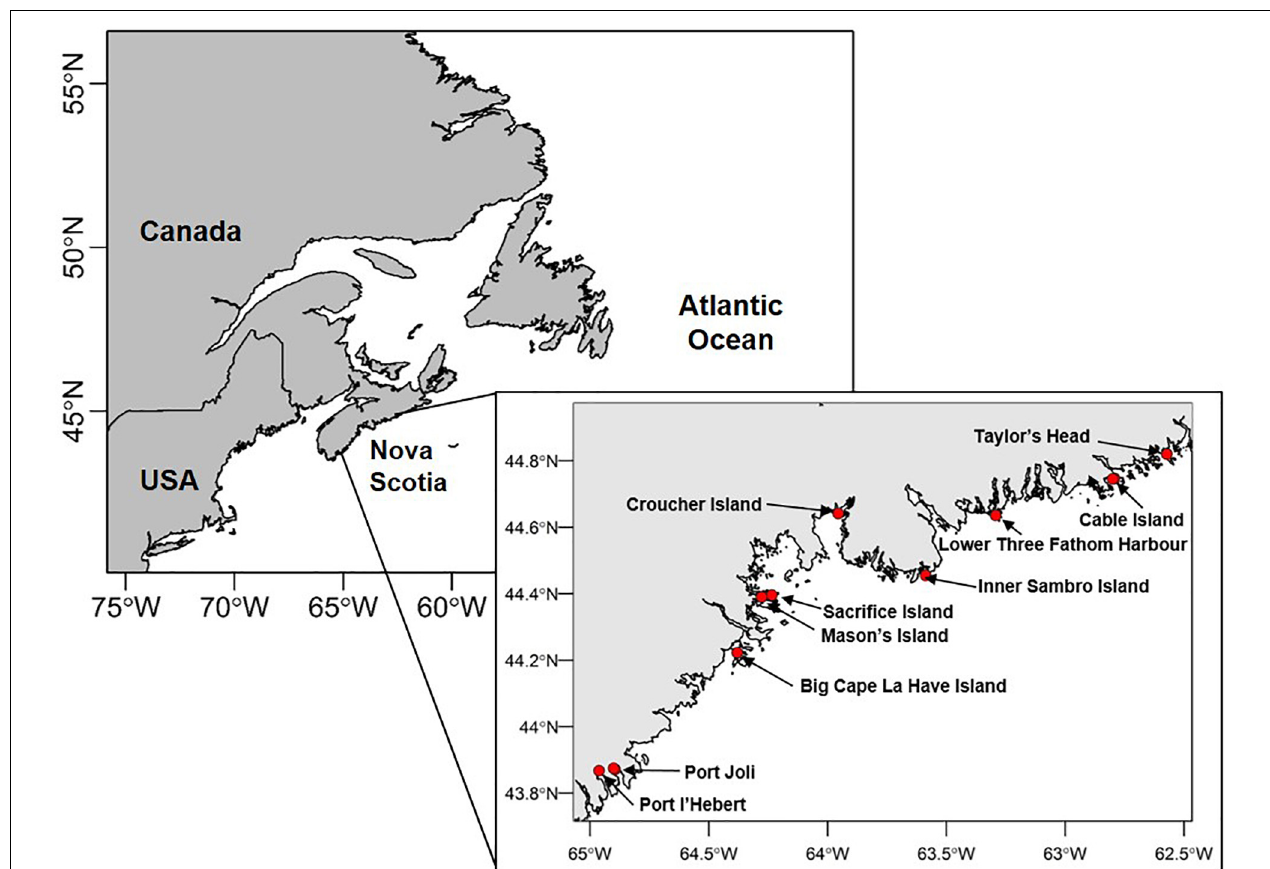
FIGURE 1 | Study sites along the Atlantic coast of Nova Scotia,